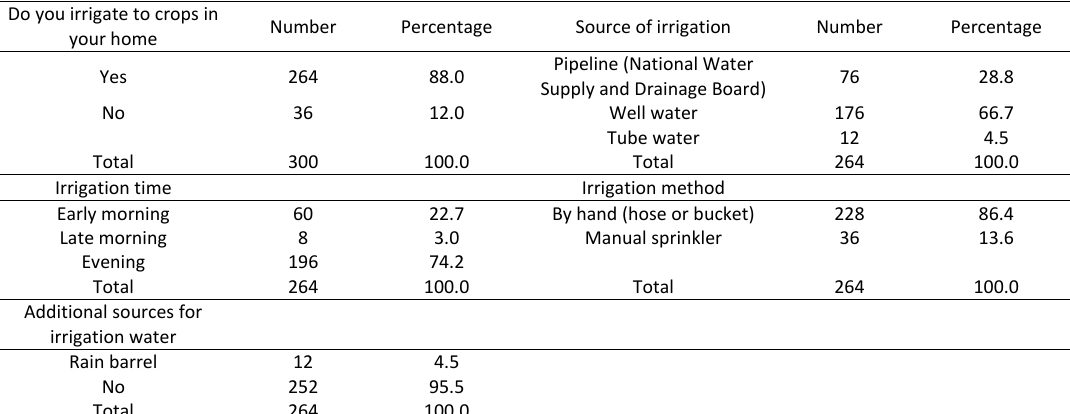
Table 4: Irrigation water management